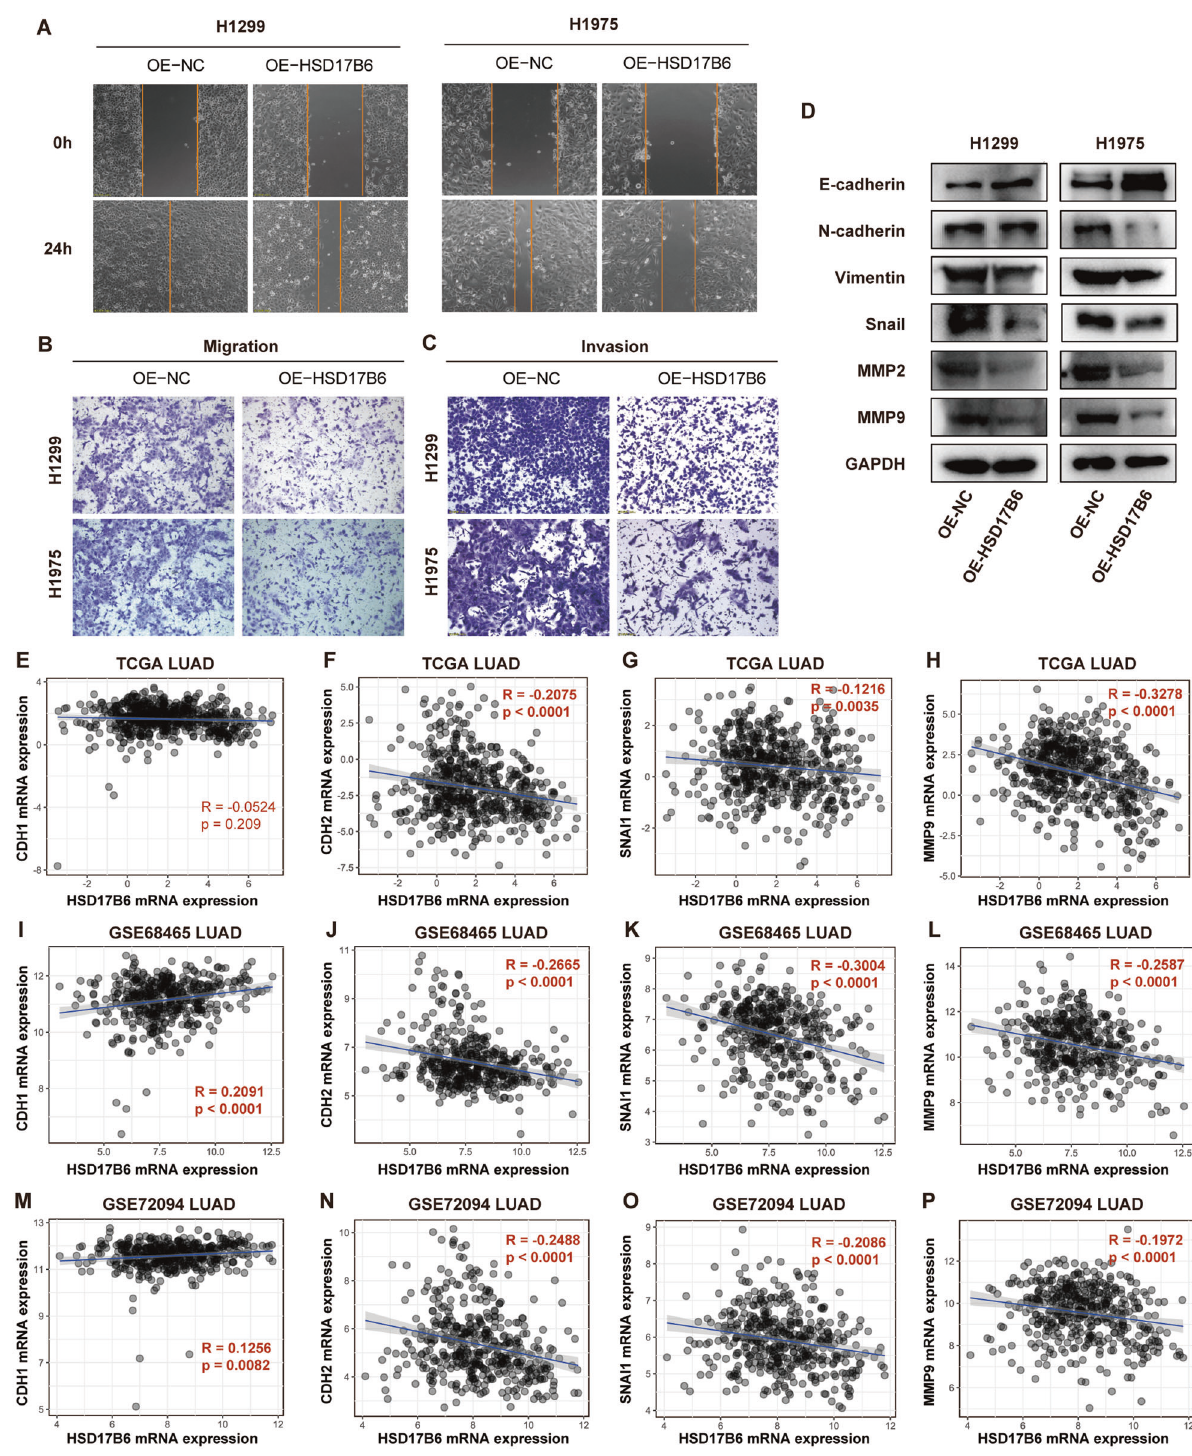
Fig. 6 HSD17B6 inhibits the cell migration and invasion of LUAD cells. A The effect of HSD17B6 overexpression on cell migration of H1299 and H1975, as determined using wound-healing assays. B, C The effect of HSD17B6 on cell migration and invasion of H1299 and H1975, as determined using transwell assay. D Protein levels of E-cadherin, N-cadherin, Vimentin, Snail, MMP2, and MMP9 were assessed by western blotting after HSD17B6 overexpression. OE-NC, negative control for overexpression; OE-HSD17B6, HSD17B6 overexpression. E – P Correlation analysis of HSD17B6 expression and expression of invasion-related genes (CDH1, CDH2, SNAI1, and MMP9) in TCGA LUAD, GSE68465, and GSE72094 datasets.